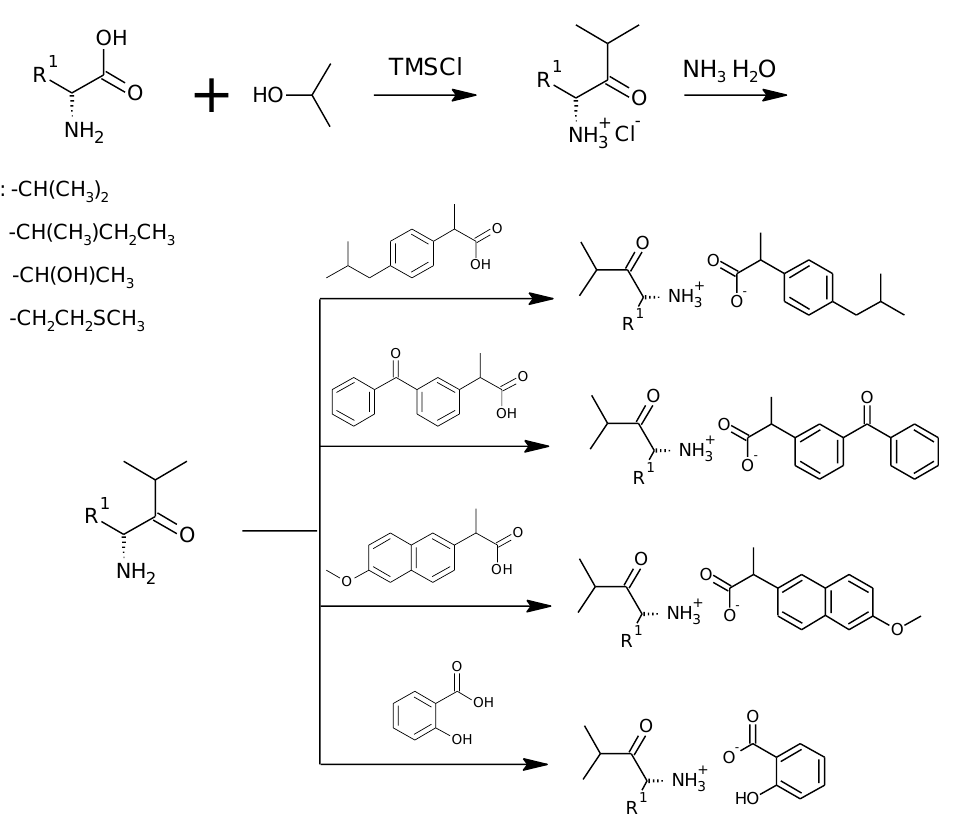
Figure 10. General synthesis pathway of L-amino acid isopropyl ester salts of selected acids from the NSAIDs group.